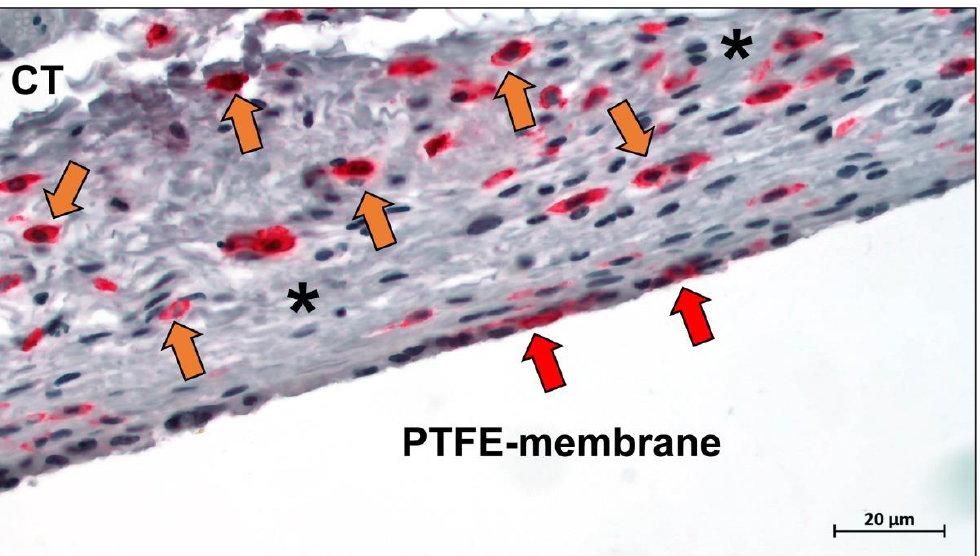
Figure 10. Representative histological image showing the pro-inflammatory tissue reaction (orange arrows = pro-inflammatory macrophages within the surrounding connective tissue, red arrows = pro-inflammatory macrophages at the material surface) to a PTFE-membrane at 30 days post implantationem. Asterisks = reactive cell wall, CT = connective tissue (CD11c immunostaining, 400 × magnification, scalebar = 20 µm).